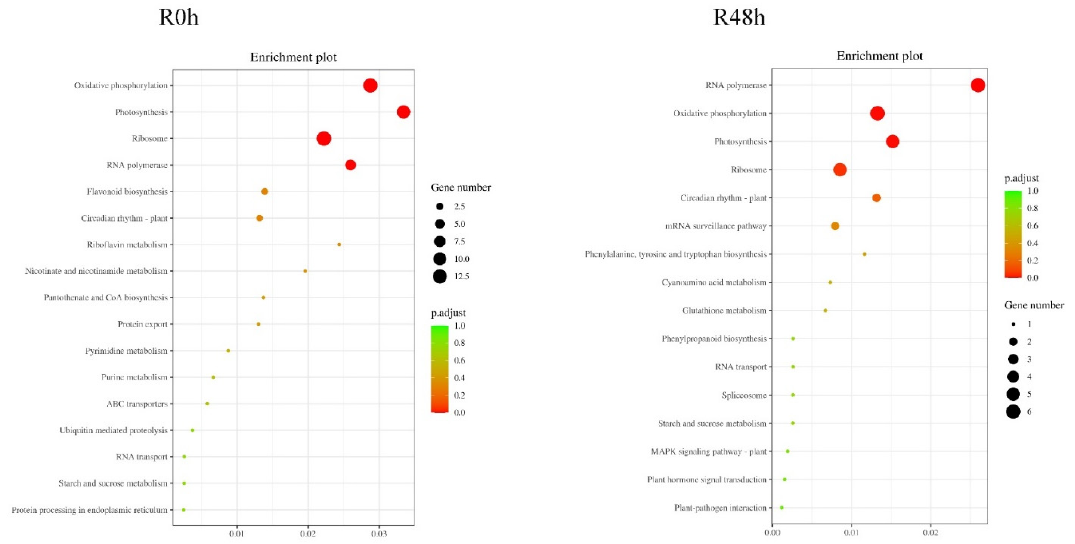
Figure 8. Venn diagram showing the overlap of peak-associated genes for R0 h and R48 h.